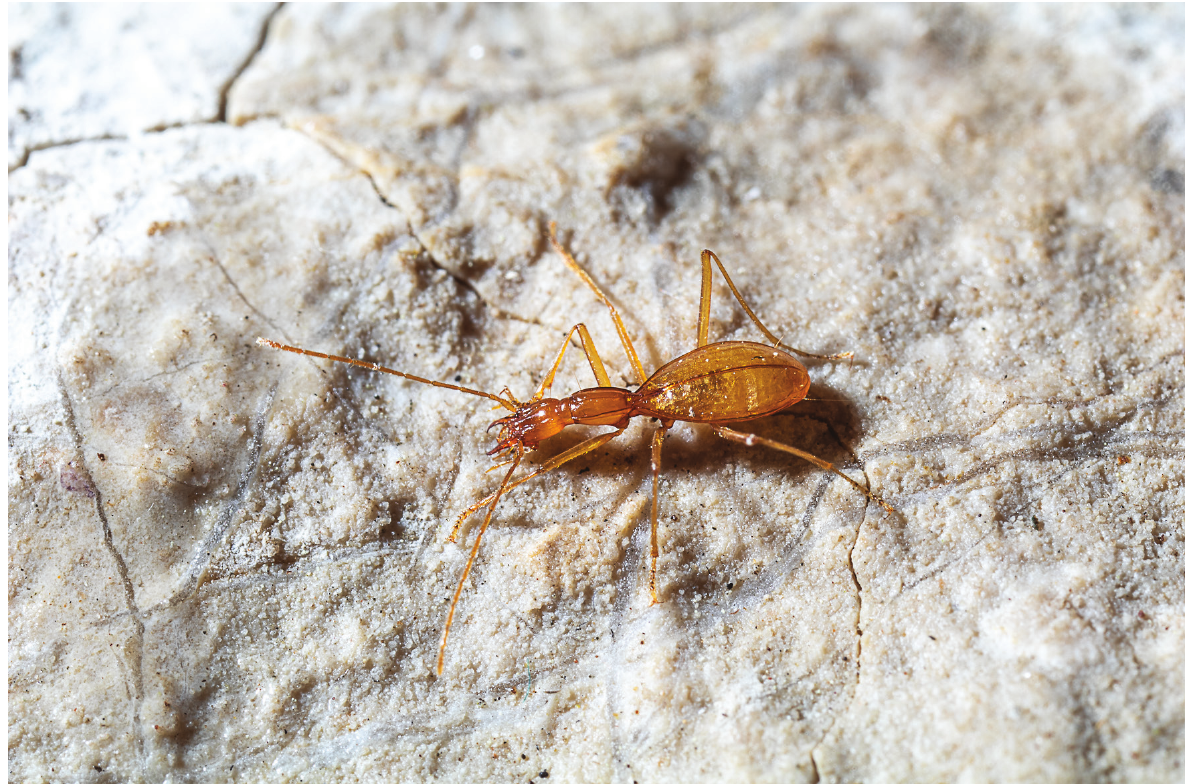
Figure 3. Derossiella lukici sp. n. in its habitat in the cave Biokovka, Golubinjak, Mt Biokovo (Photo courtesy of P. Bregović).